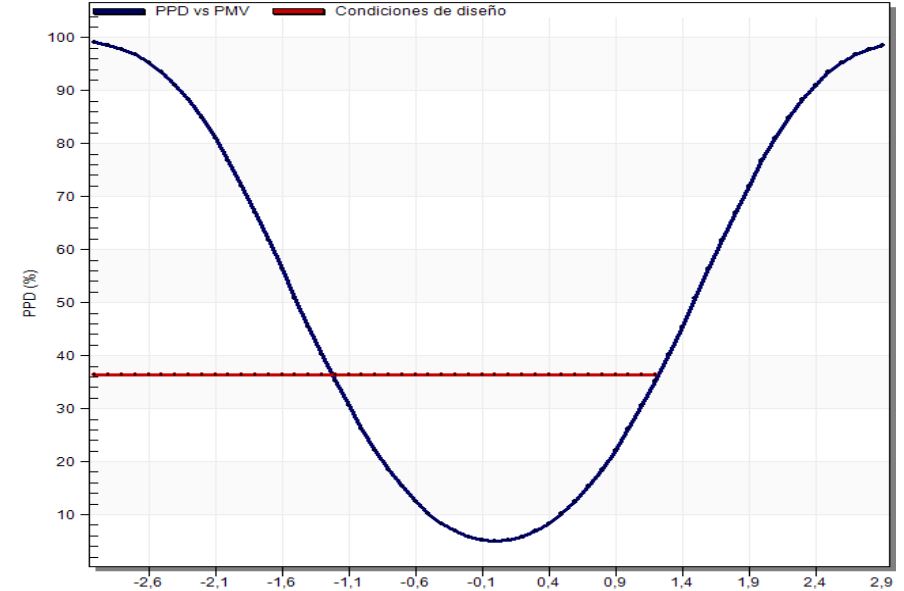
Figure 6 . Graph of the thermal comfort of the house case study with the provision of the PPD VS PMV crossed with the design